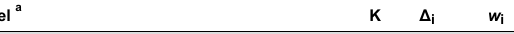
Table 2. Summary of top three models describing variation in habitat selection by roe deer at the spatial and temporal scales of home ranges and seasons at Grimsö Wildlife Research Area in 1984-2007 (see Table S1 for complete list of models).